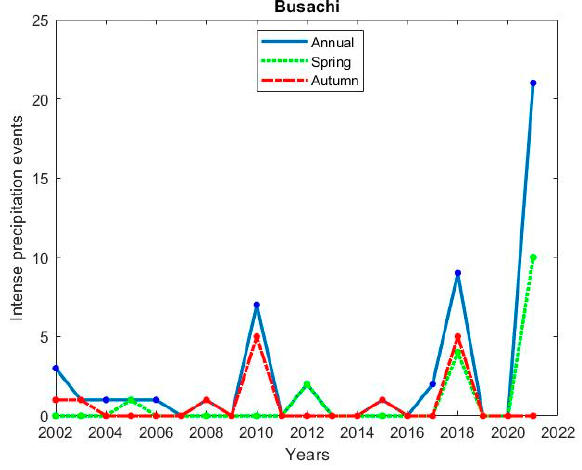
15 of 23 Figure 6. Trend of cumulative annual precipitation (mm) over the past twenty years (2002-2021) for the Busachi case study. As in Paternò, there seems to be a reduction in precipitation patterns for Busachi: starting in 2014 a lack of smoothness in the trend of interannual cumulative precipitation is observed. Now, it is useful to look at seasonal trends to see what the contribution of individual seasons might be to the overall annual contribution. Figure 7a,b shows the cumulative seasonal precipitation trends. ( a ) ( b ) Figure 7. Seasonal cumulative precipitation trends: ( a ) in winter and autumn, ( b ) in spring and sum- mer, for the Busachi case study. Figure 7a shows how Busachi has experienced a reduction in winter cumulative pre- cipitation over the past twenty years, while in autumn an increase has been experienced. Although the cumulative precipitation values for these two seasons are slightly lower than those of Paternò, the same trends are observed for both Busachi and Paternò. Turning then to Figure 7b, the spring and summer trends both show decreasing trends, as seen for